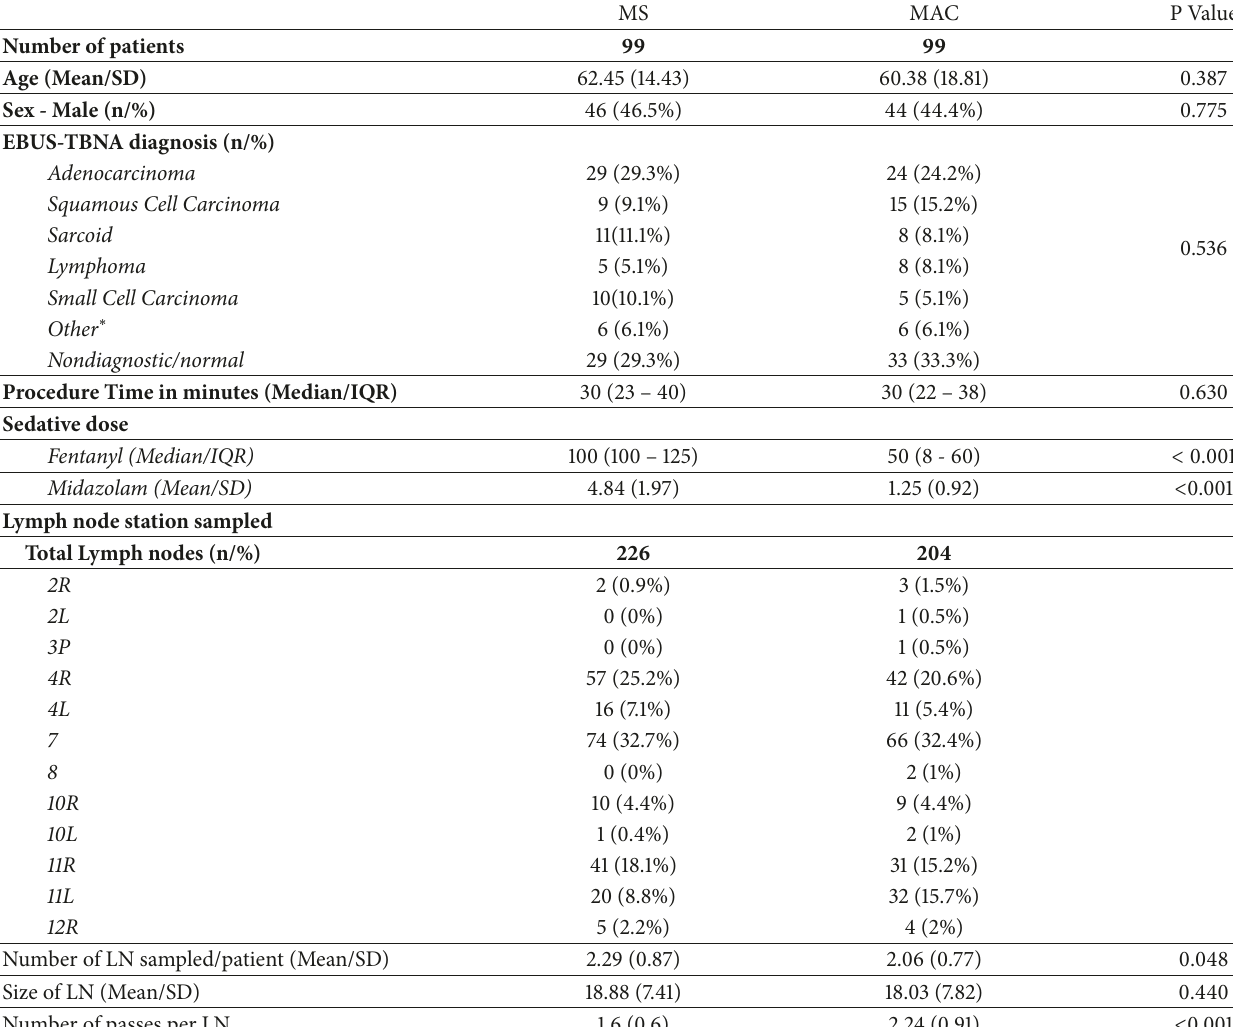
Table 1: Patients and procedure characteristics.